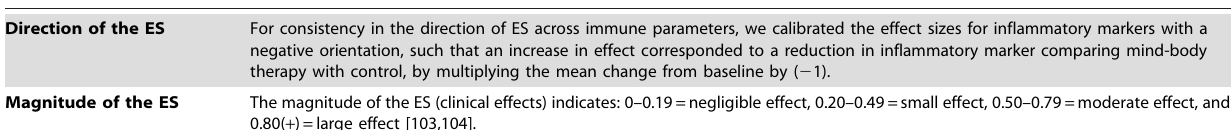
Table 3. Technical details on the interpretations for effect size (ES).